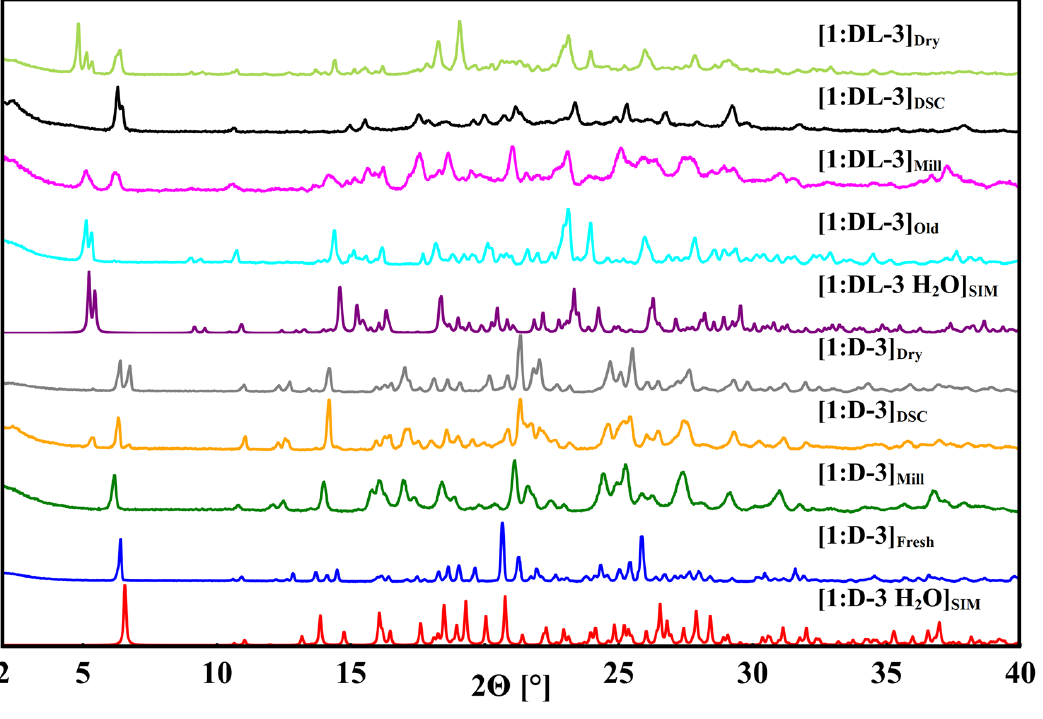
Figure 3 . PXRDs of Baclofen:tartaric acid systems under different conditions in a range 2–40° 2 Θ . Simulated pattern of 1 : D − 3 • H 2 O from single crystal data (red); recorded pattern from (blue) a fresh sample of said substance shortly after crystallization; LAG sample of Baclofen and D − tartaric acid